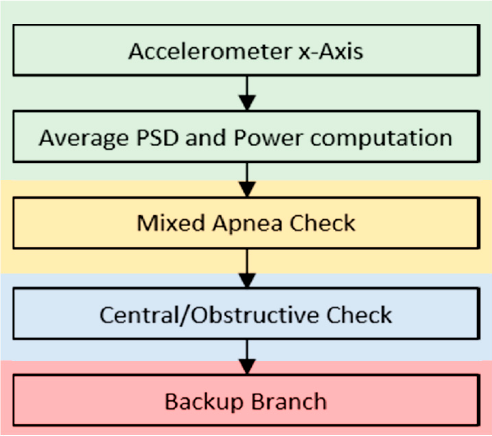
Figure 15. Phenotype classification block scheme.